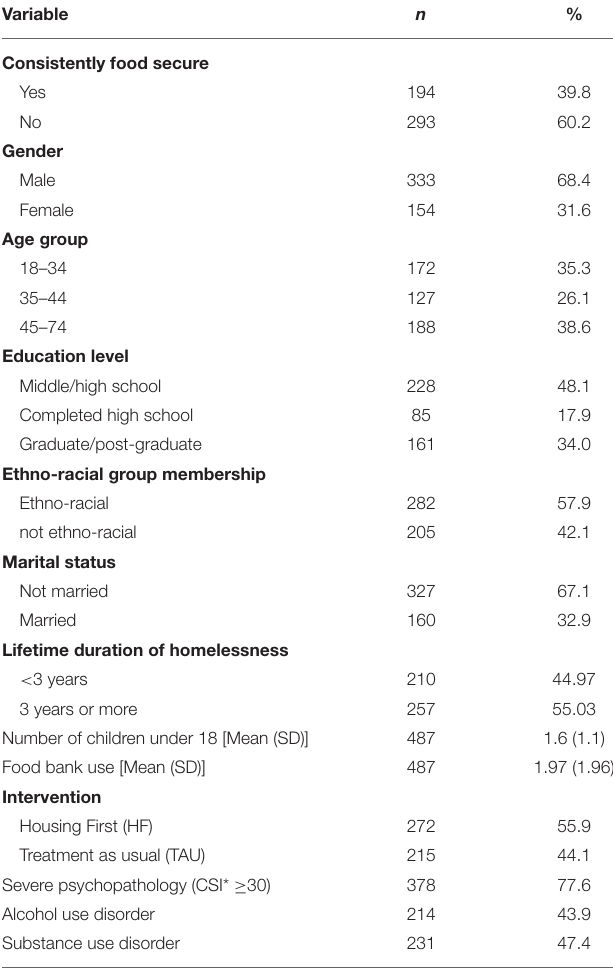
TABLE 1 | Characteristics of the At Home/Chez Soi participants at baseline ( n =